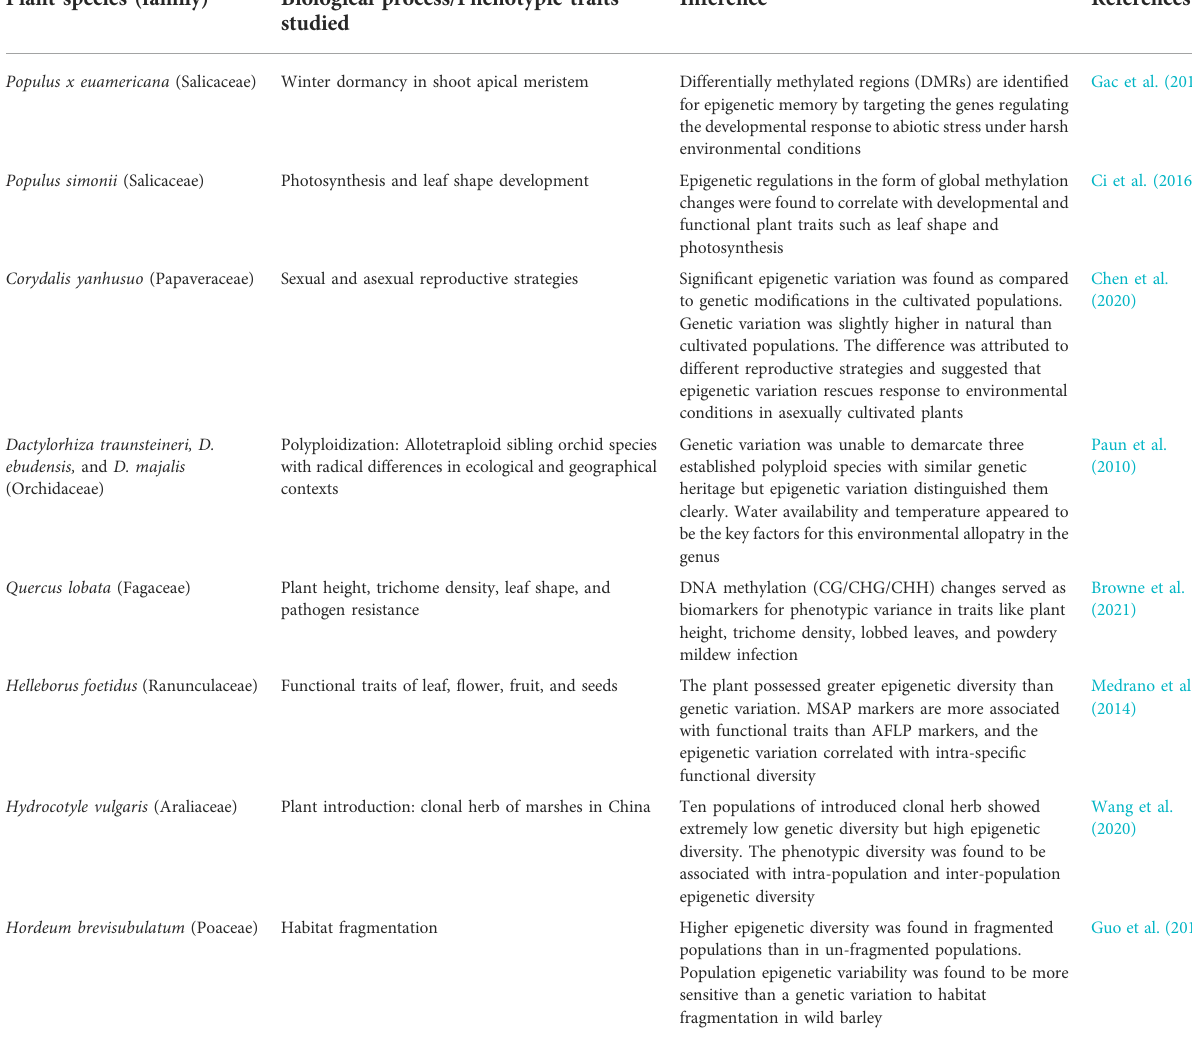
TABLE 3 Epigenetic regulation during various biological processes and functional traits development in natural plant populations. Plant species